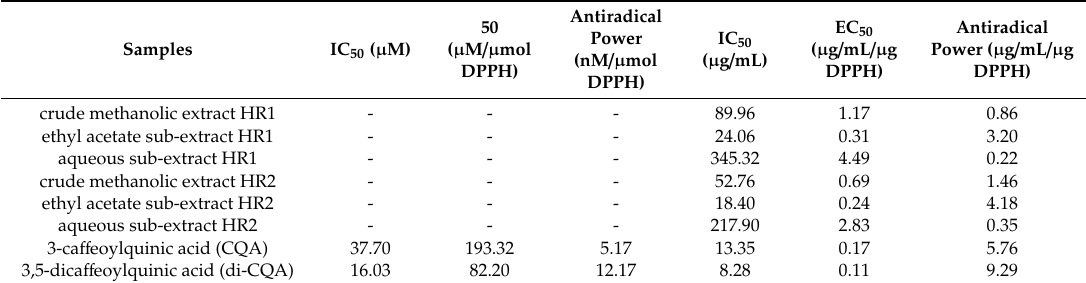
Table 3. DPPH radical scavenging activities of the di ff erent Cichorium intybus L. (chicory) hairy root preparations and ca ff eoylquinic acid derivative